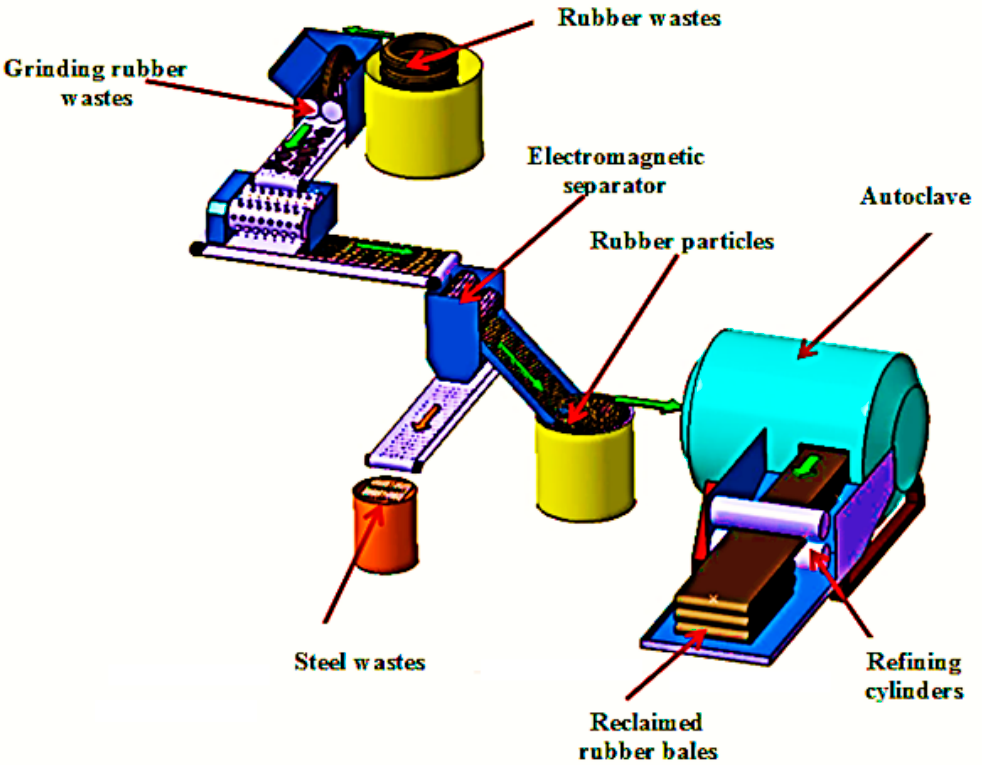
Figure 2. The structure of the technological process of obtaining reclaimed rubber by devulcanization in autoclave.